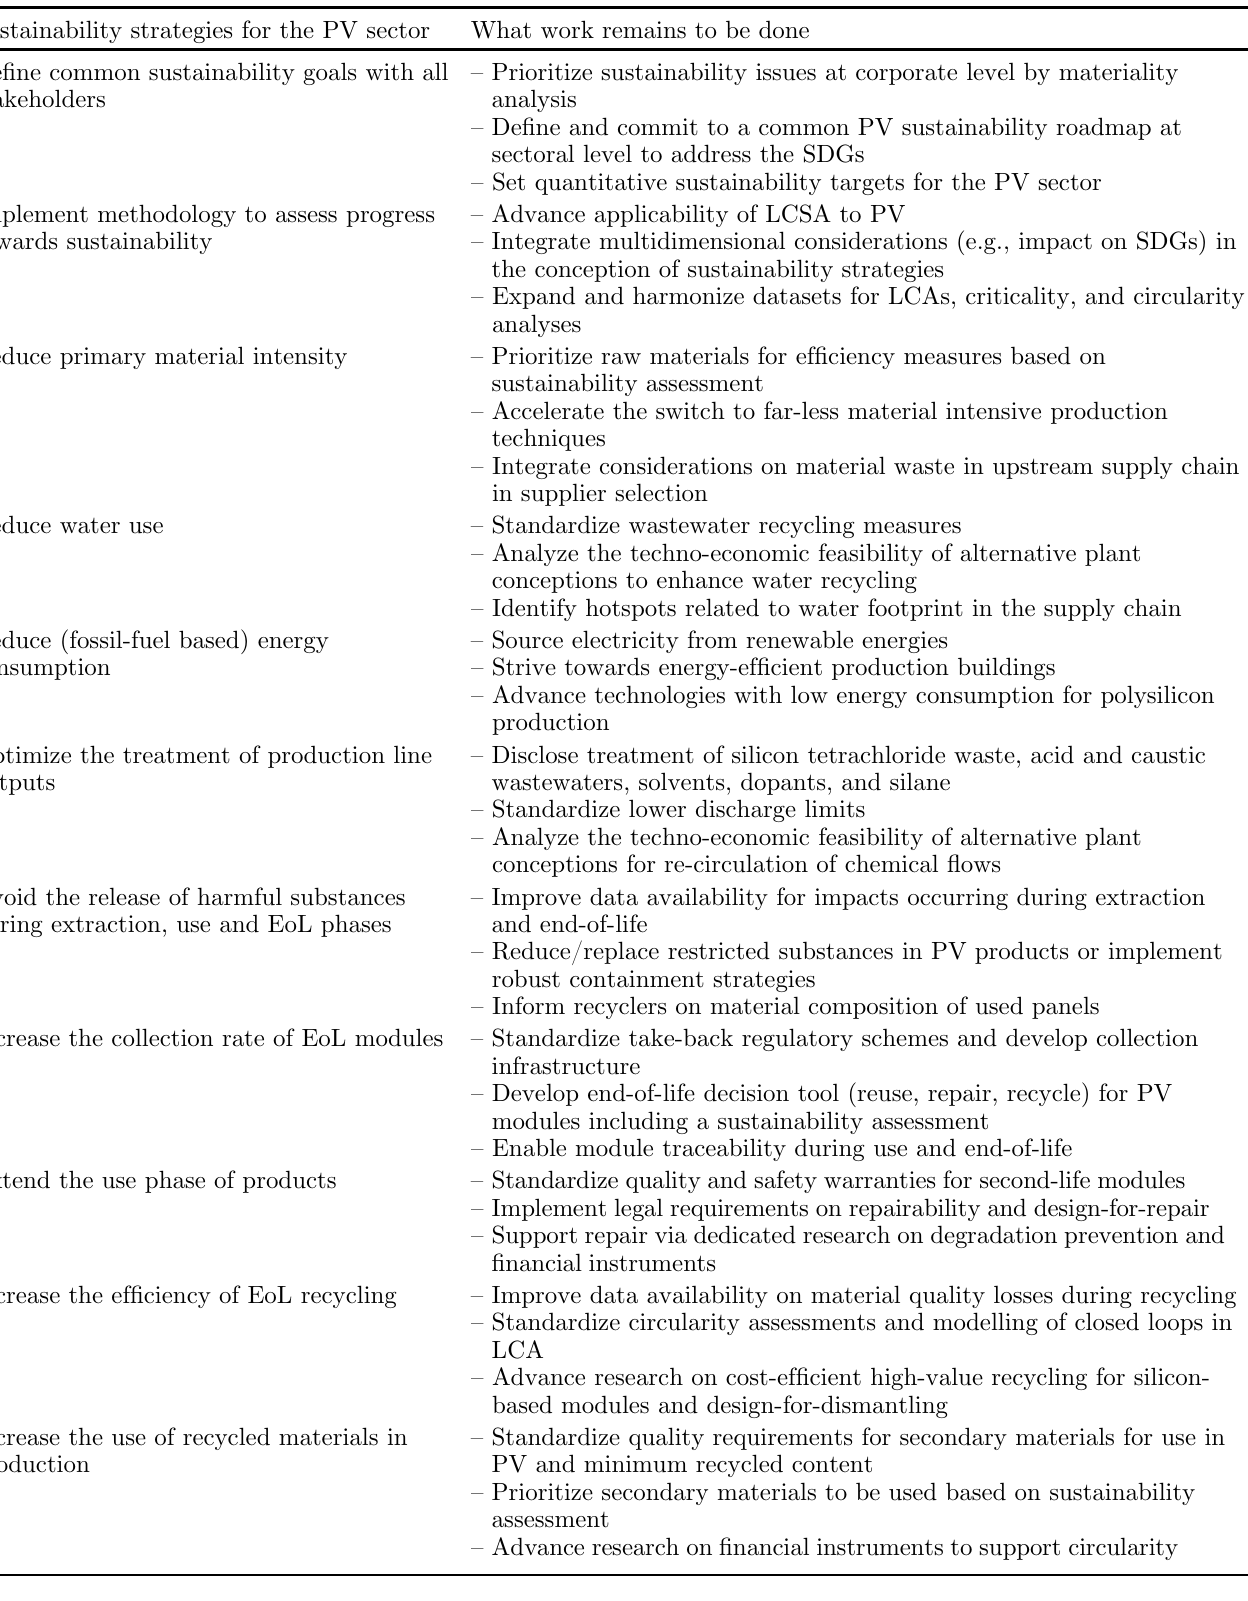
Table 3. List of actions for the PV sector to address SDG 12. It is by no means exhaustive but provides a starting point for all stakeholders to improve the sustainability in PV value